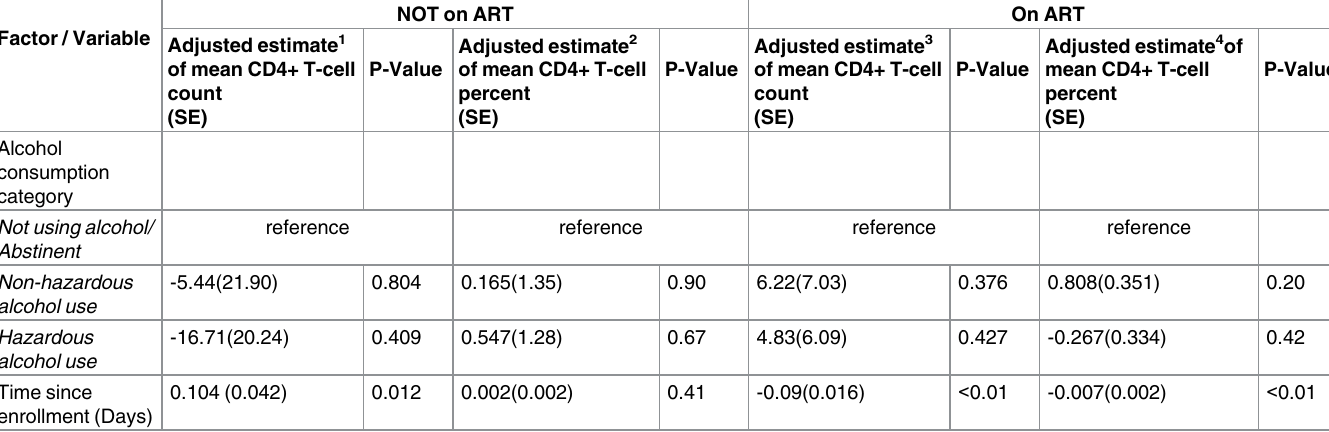
Table 3. Final adjusted linear mixed effectsregression of adjusted mean CD4+ T-cell count square-root andCD4+ T-cell percent among of partici- pants with non-hazardous and hazardous alcohol use compared with non-alcohol users, stratified by ART receipt at the Infectious diseases Insti- tute, Kampala